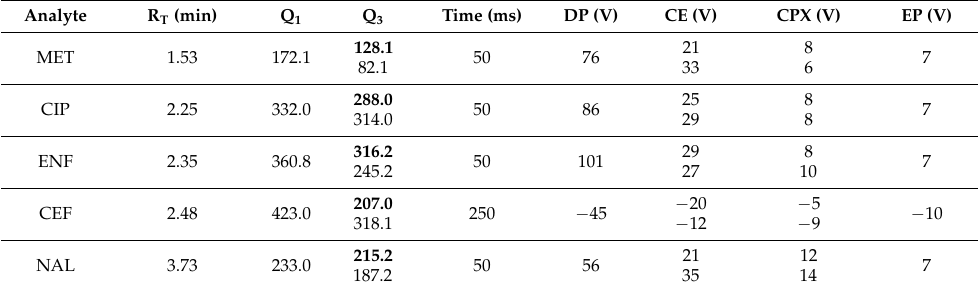
Table 3. Multiple reaction monitoring (MRM) conditions for the analysis of the selected antimicrobials.